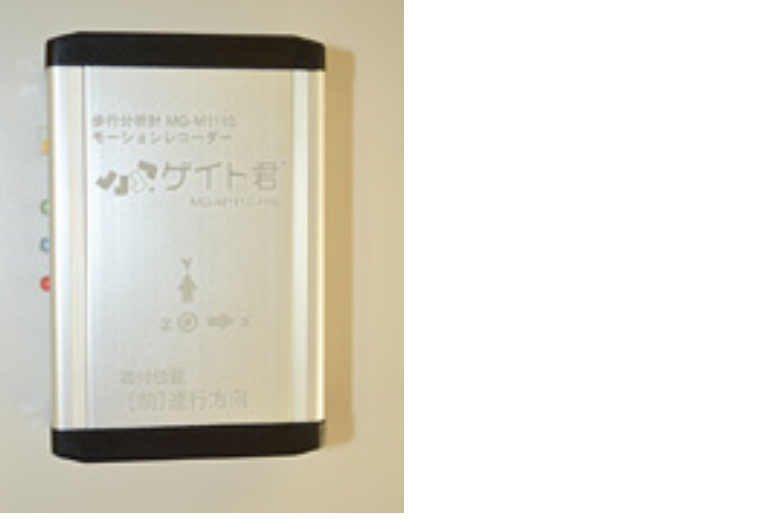
Figure 1. Portable gait rhythmogram (MG-M 1110, LSI Medience Corporation, Tokyo, Japan). Size = 8 × 6 × 2 cm. Weight = 80 g.